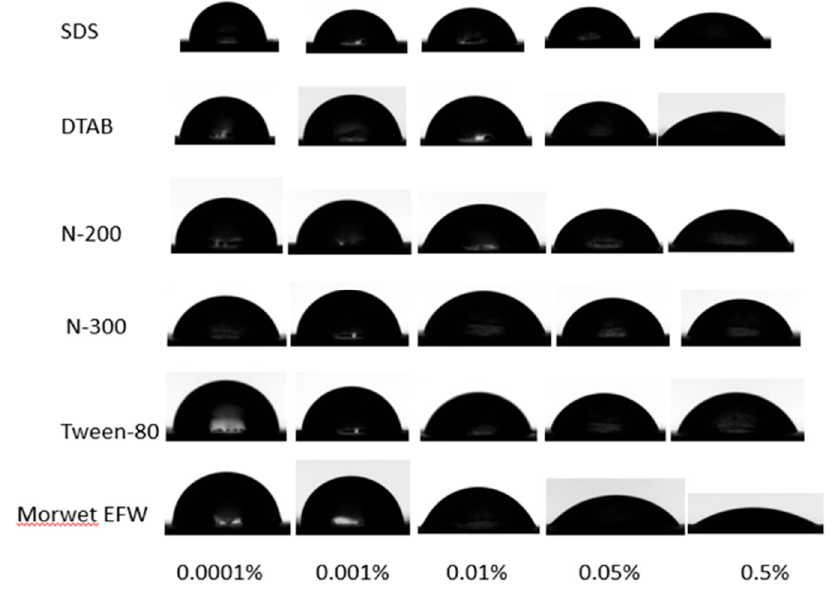
Figure 4. Optical images of contact angles on tea leaf surfaces according to the wetting stage.